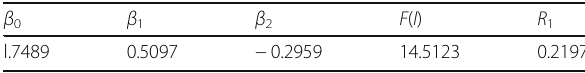
Table 1 Parameter estimate and testing